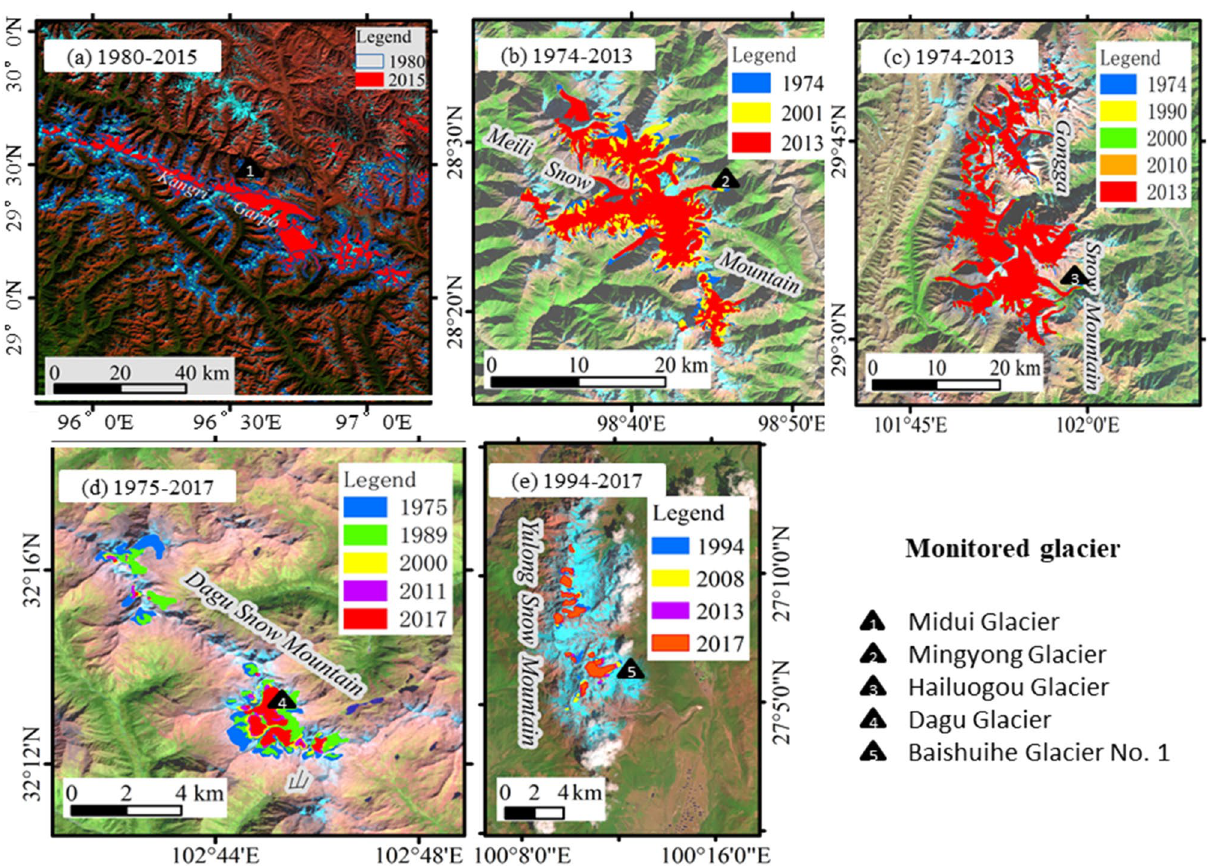
Figure 2. Spatial distribution of glaciers change on Kangri Garpo ( a ), Meili (MSM) ( b ), Gongga (GSM) ( c ), Dagu (DSM) ( d ) and Yulong Snow Mountains (YSM) ( e ) during different periods. The satellite images were provided by U.S. Geological Survey (USGS; https ://earth explo rer.usgs.gov). The final maps of glacier change were created by ArcMap version 10.2 (http://deskt op.arcgi s.com/en/arcma p/).